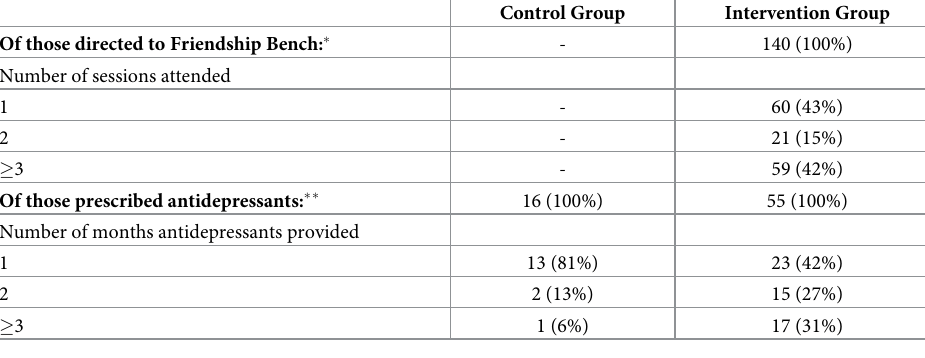
Table 4. Depression treatment over